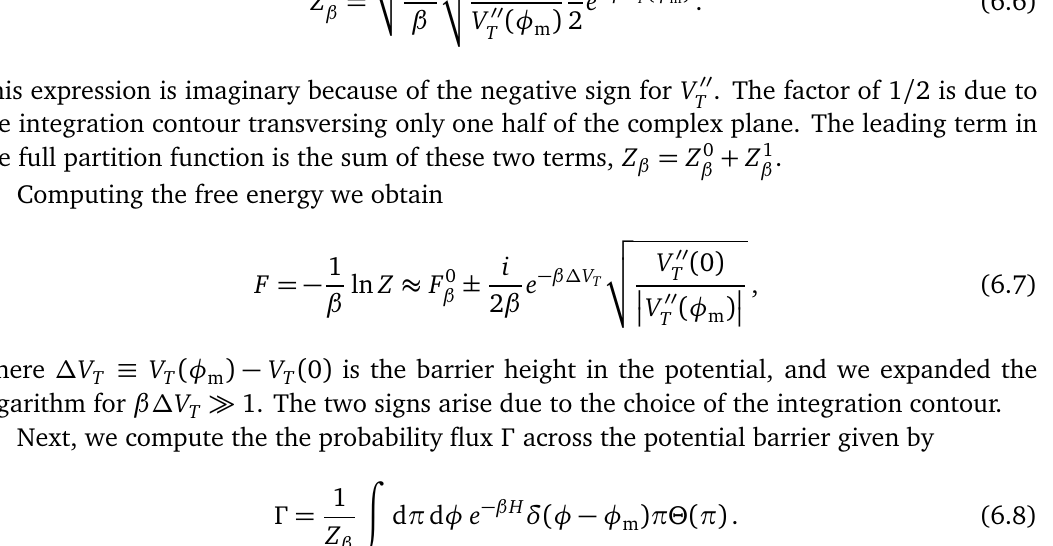
( φ ) for a temperature below the critical Figure 8: The effective thermal potential V T temperature, T < T . The potential has two minima φ = 0 an φ = φ c maximum at φ = φ , which we use for the saddle point approximation. Due to m thermal fluctuations, the field can transition from the symmetric phase to the Higgs